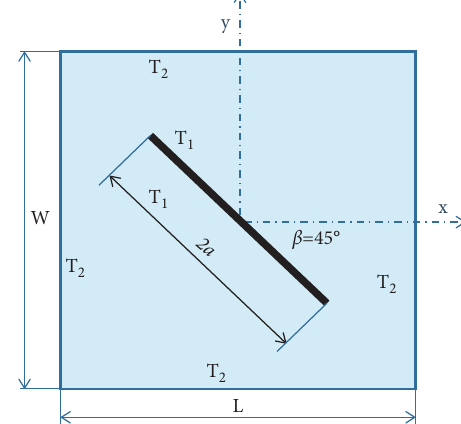
Figure 14: Square plate domain with an inclined crack: isothermal crack T